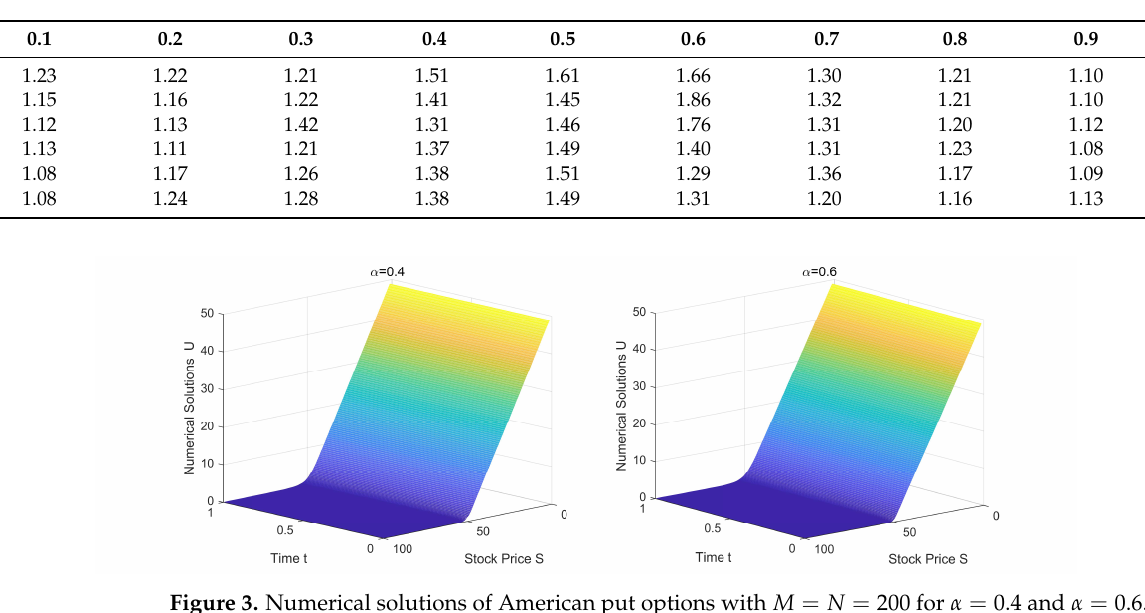
Table 6. The order of convergence for American put options using the RBF-FD-IL1-OS method with M = 40.